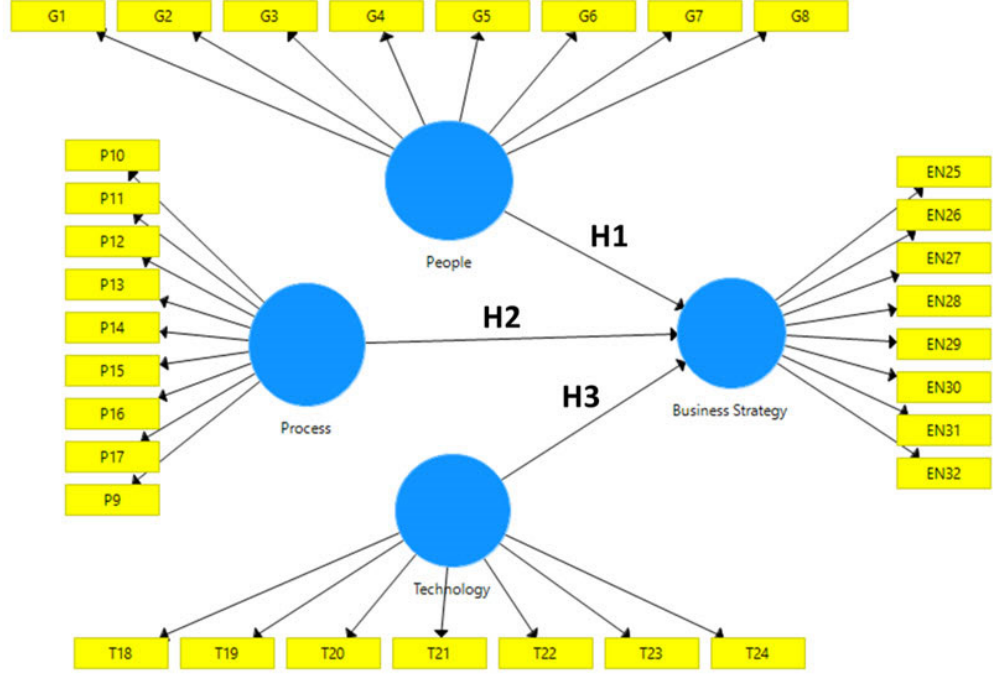
Fig. 1 . Proposed research